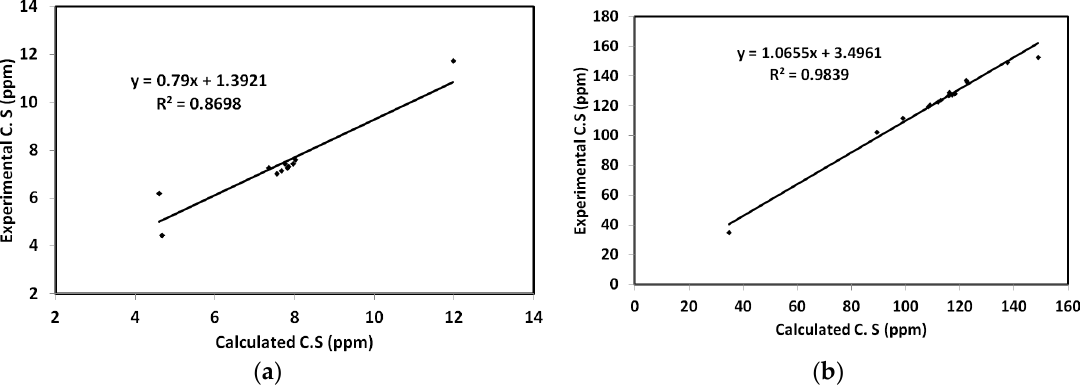
Figure 11. Correlation graphs between the calculated and experimental 1 H ( a ) and 13 C ( b ) NMR chemical shifts.